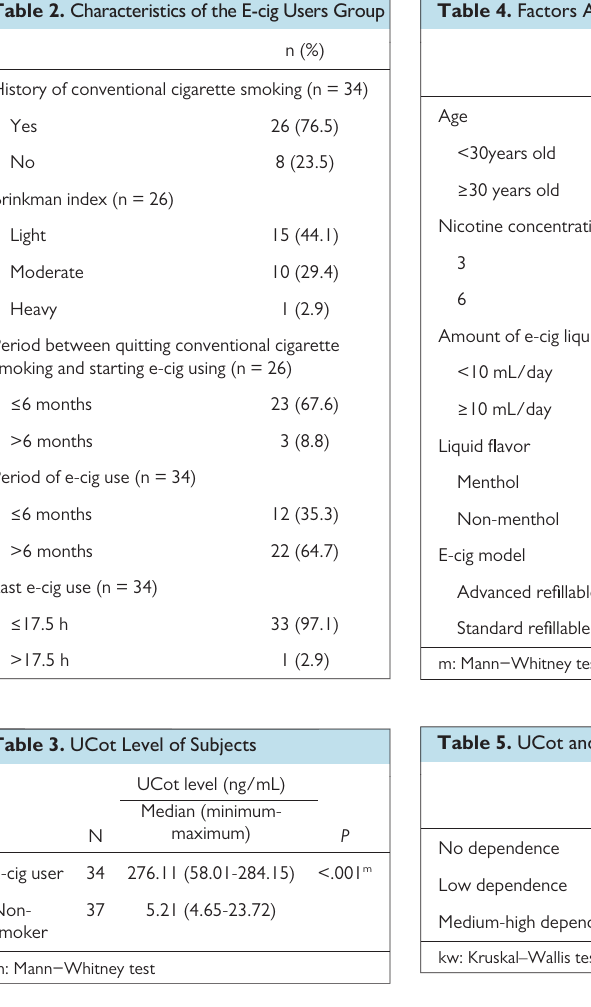
Table 2. Characteristics of the E-cig Users Group